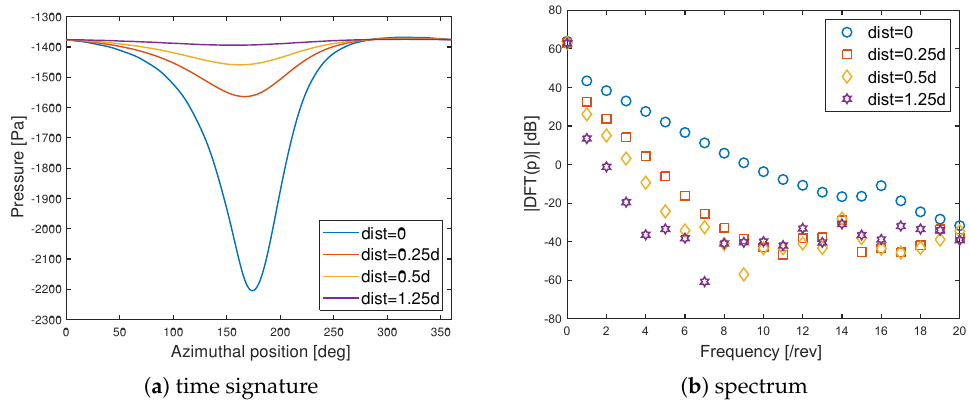
Figure 5. Aerodynamic pressure evaluated at y = 0.75 R and x = 0.25 c on rotor #1 for four different distances between rotor #1 and #2 (twin-propeller